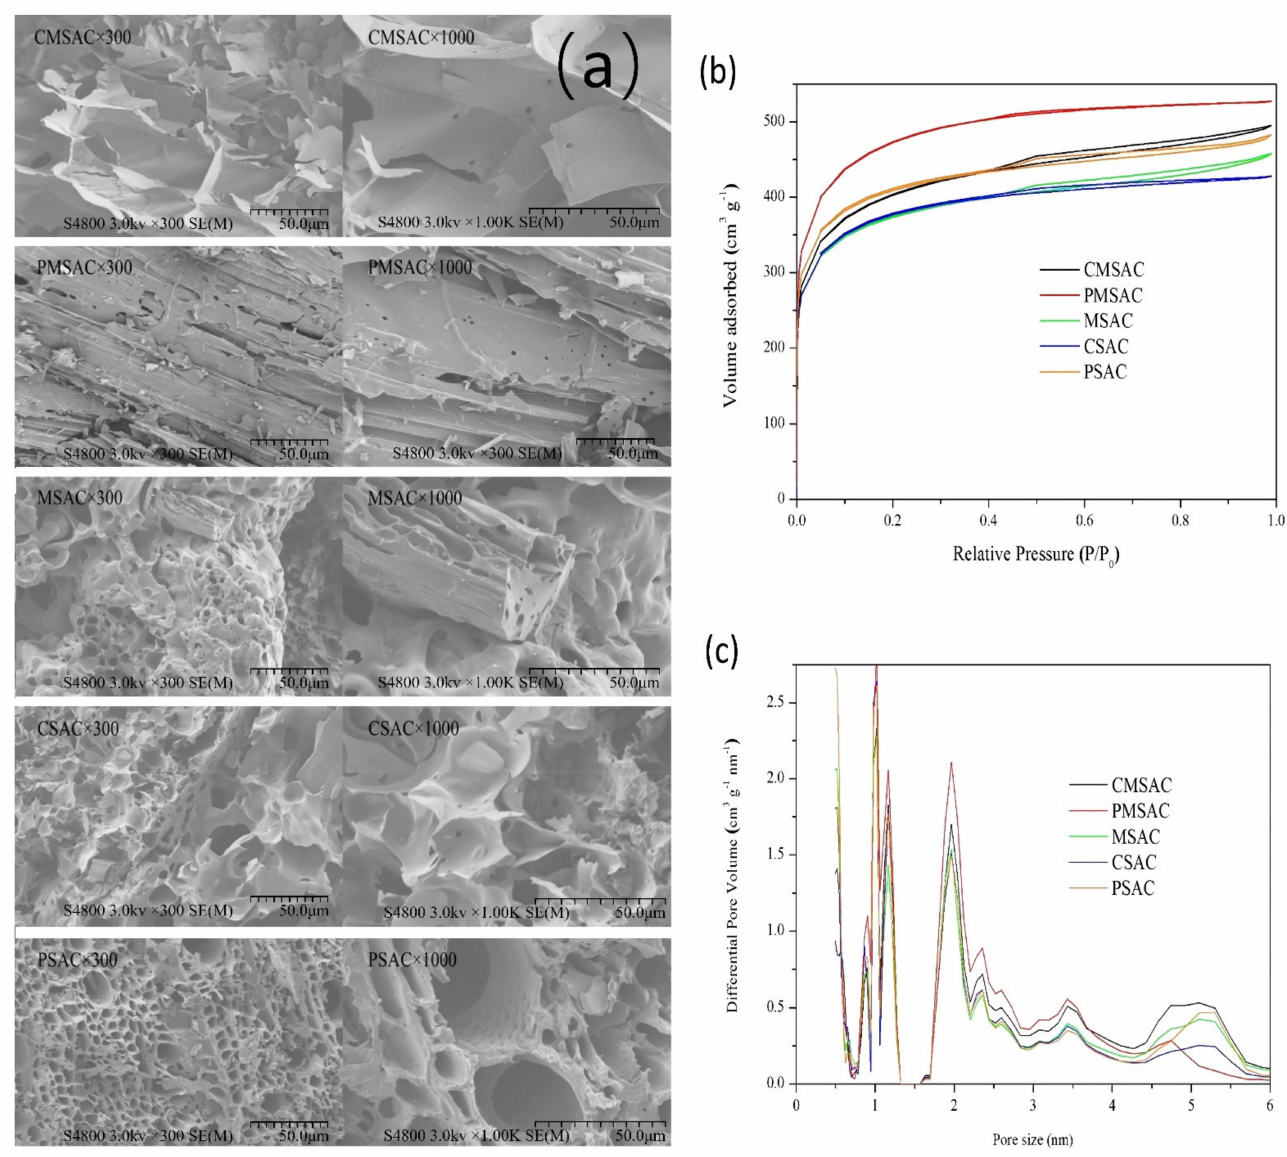
Figure 3. Characterization of different SACs: ( a ) SEM images, ( b ) N2 adsorption–desorption isotherms and ( c ) pore size